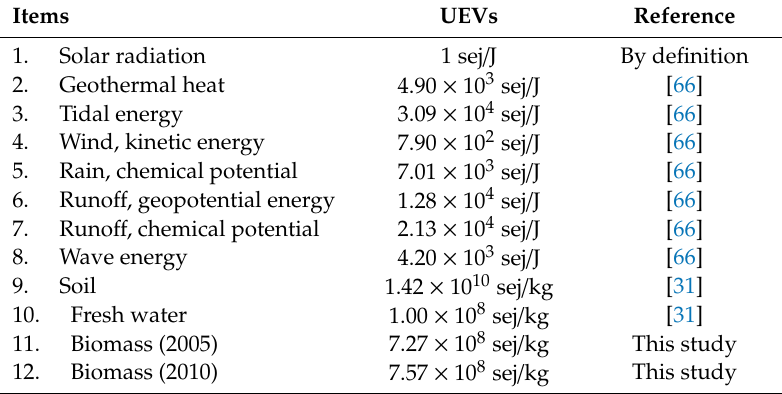
Table A5. UEVs used in this study based on 12.0 × 10 24 sej / yr emergy